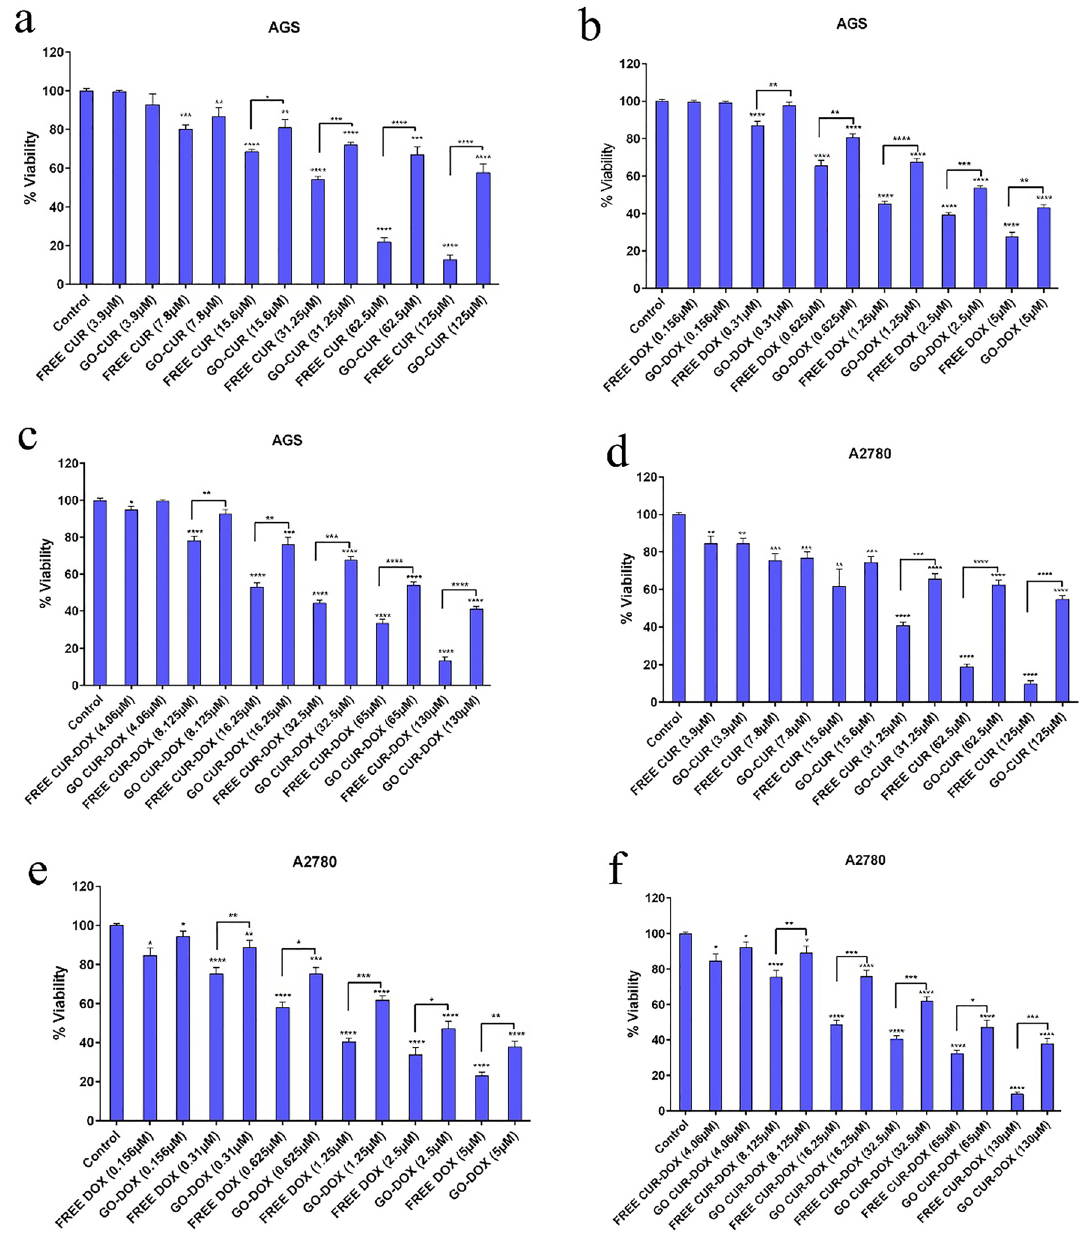
Figure 10. Cytotoxicity analysis of ( a ) different concentration of free CUR and GO-CUR in AGS after 48 h, ( b ) different concentration of free DOX and GO-DOX in AGS after 48 h, ( c ) different concentration of free CUR- DOX and GO-CUR-DOX in AGS after 48 h, ( d ) different concentration of free CUR and GO-CUR in A2780 after 48 h; ( e ) different concentration of free DOX and GO-DOX in A2780 after 48 h; ( f ) different concentration of free CUR-DOX and GO-CUR-DOX in A2780 after 48